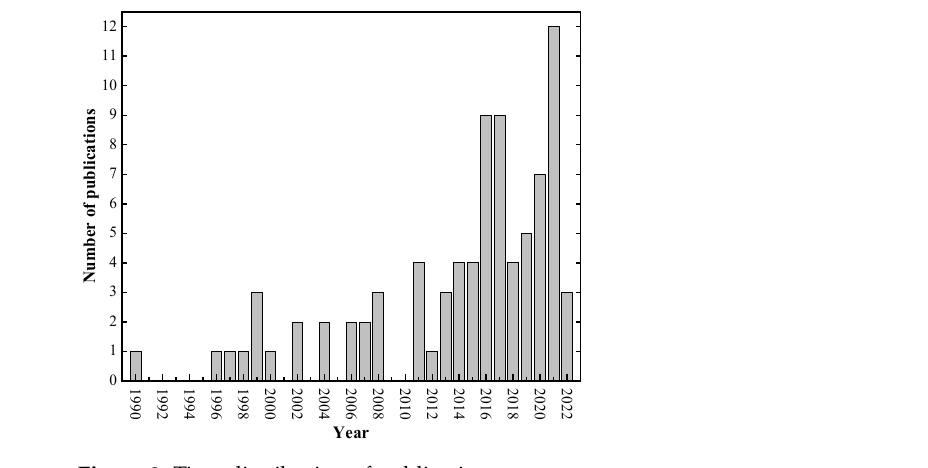
Figure 3. Time distribution of publications.